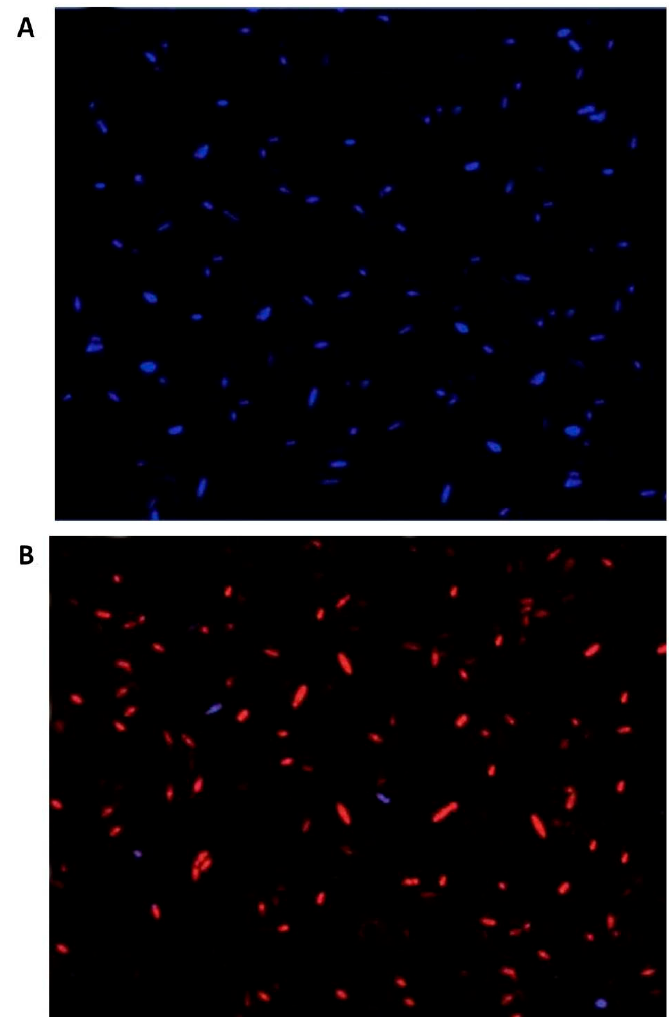
Figure 4. Analysis of fungal cell viability by fluorescence microscopy. F. oxysporum spores ( A ) non-treated or ( B ) treated with rGO-CuO NPs were stained with DAPI (stains live spores in blue) and PI (stains dead spores in red) and visualized.